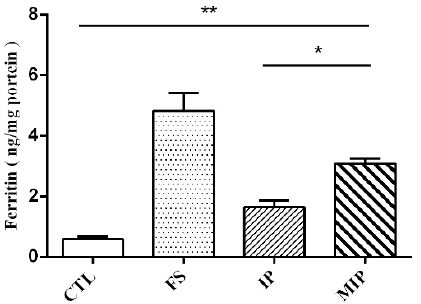
Figure 6. Ferritin levels in mono-cultured Caco-2 cells treated with iron. CTL: control; FS: FeSO 4 · 7H 2 O; IP: commercial iron particles; MIP: mesoporous iron particles. All data are presented as mean ± SD ( n = 3). The result s compared with control group, * p < 0.05; ** p < 0.01.